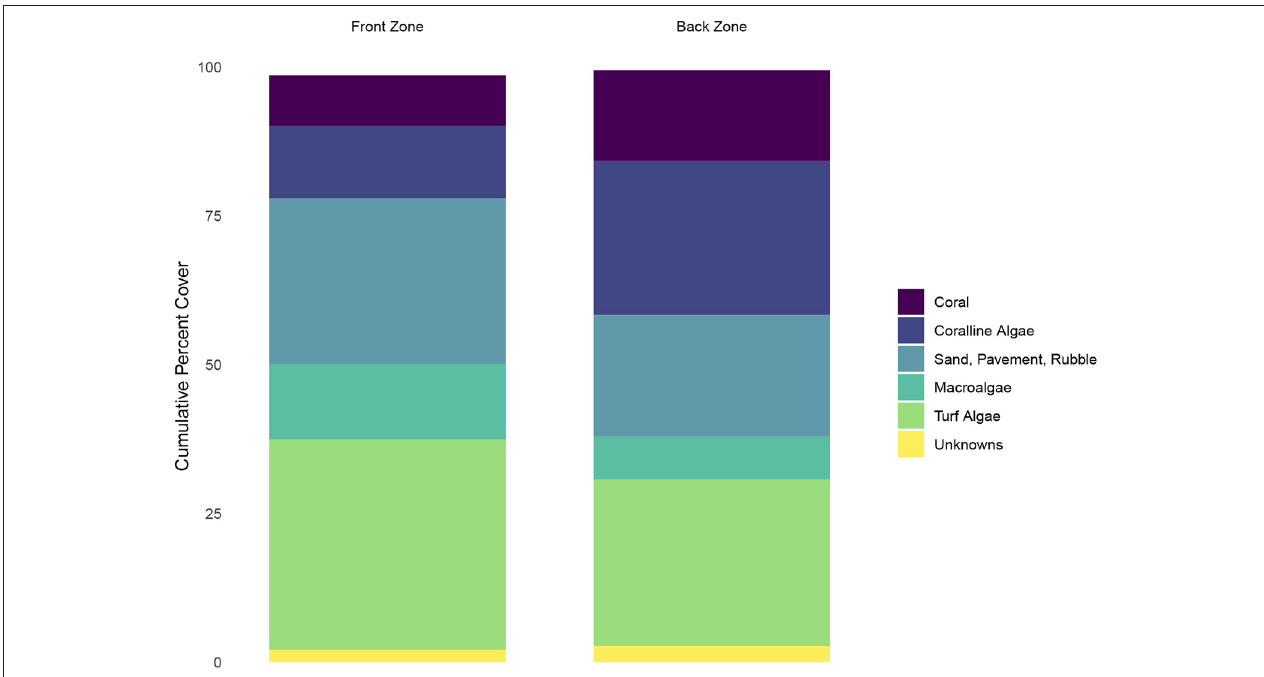
FIGURE 2 | Ecological community composition of the front and back zones on the reef. Calcifers (corals and coralline algae) are show in opaque, while the other functional groups are shown in semi-transparent color to highlight the differences in calcifier abundance between the two zones.